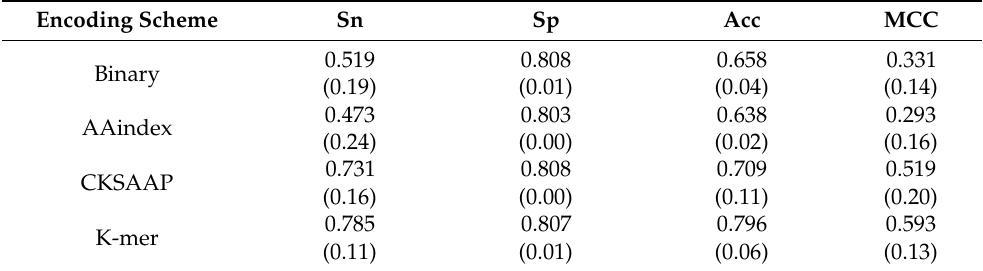
Table 1. Prediction performance of the single encoding-employing models without any feature selection on the training dataset by five-fold cross-validation (CV). CKSAAP, composition of k-spaced amino acid pairs. MCC, Matthew’s correlation coefficient.